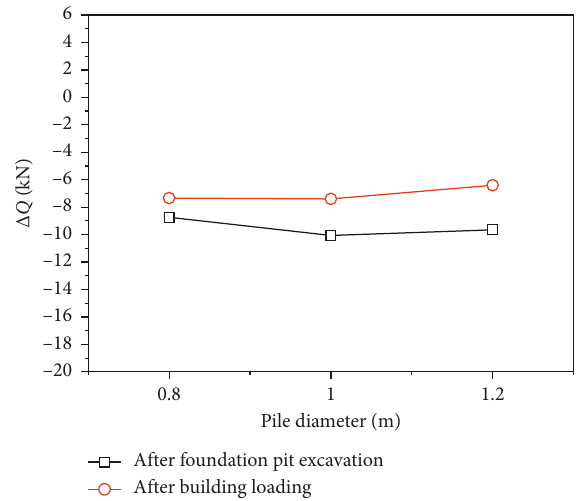
Table 15: Orthogonal experiment results of the numerical